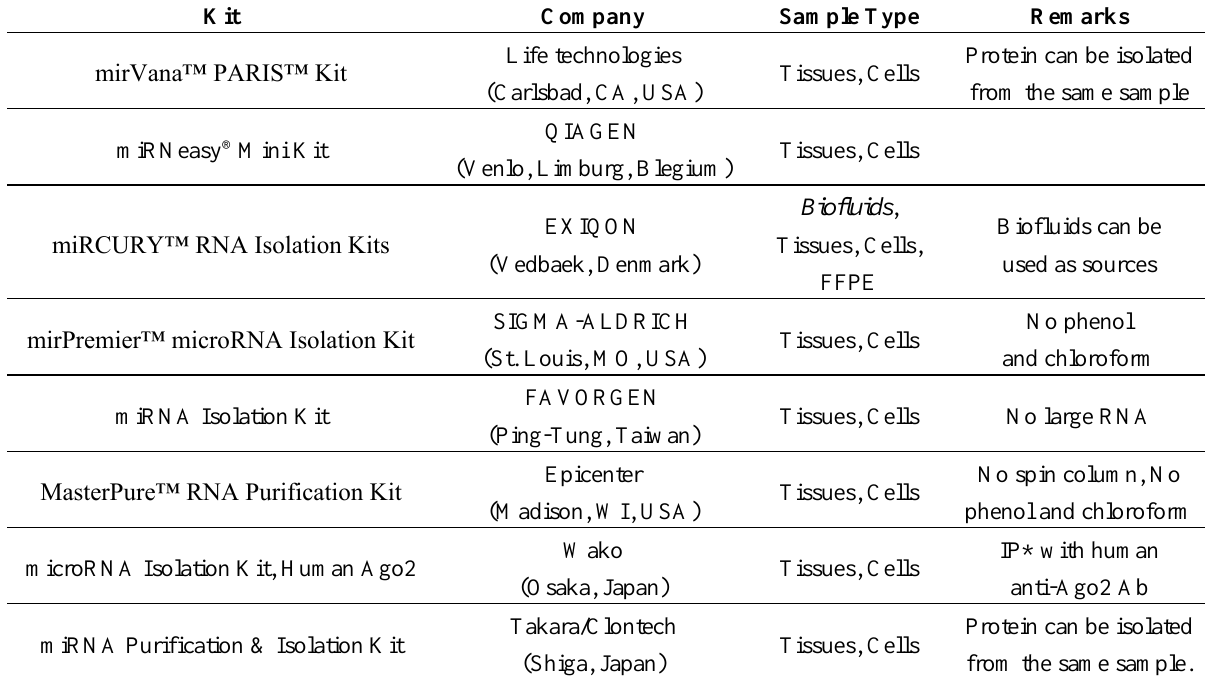
Table 2. Commercially available miRNA extraction